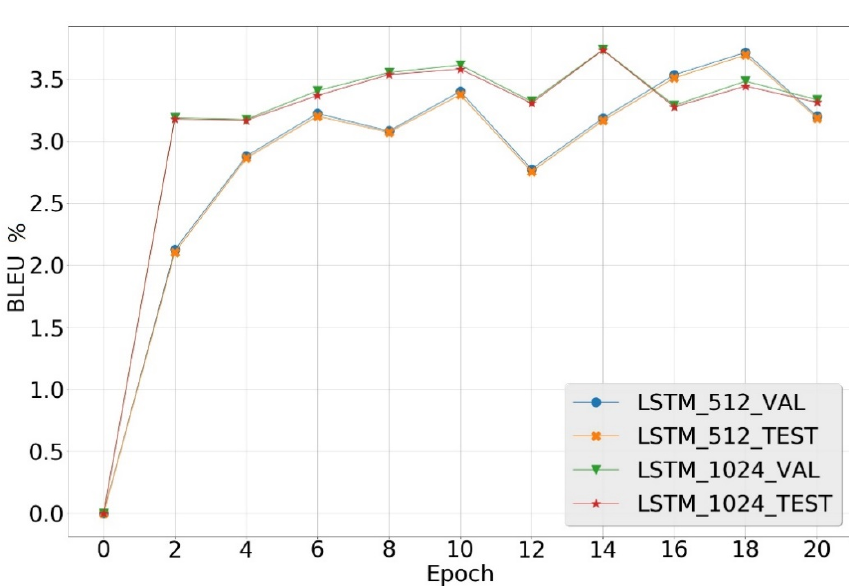
Figure 12. Bilingual understudy evaluation (BLEU) of Cases 1 and 2.